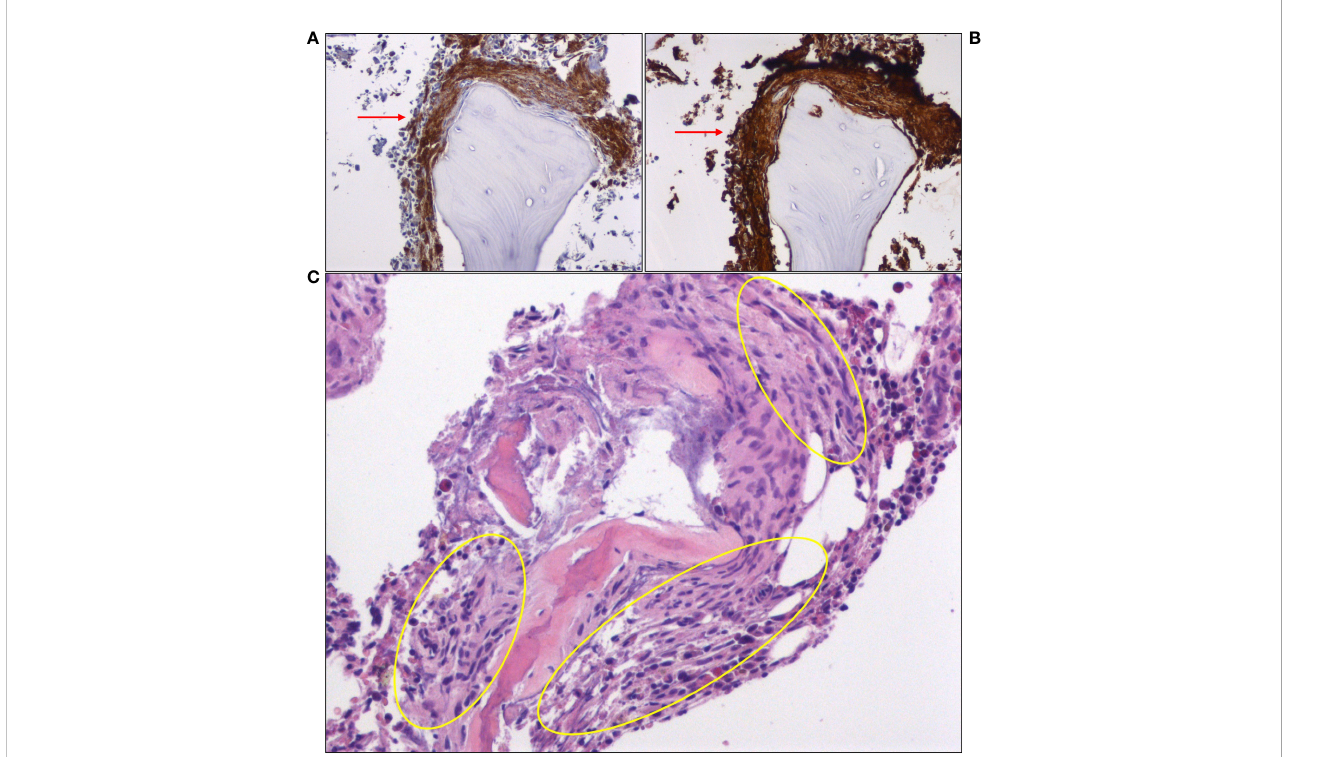
FIGURE 3 Immunohistochemical staining of bone marrow biopsy showing large clusters of mast cells (red arrows), expressing (A) CD25 and (B) mast cell tryptase. (C) A hematoxylin and eosin (H&E)-stained section of bone marrow core shows areas of paratrabecular fi brosis, in which mast cells can be identi fi ed (yellow oval